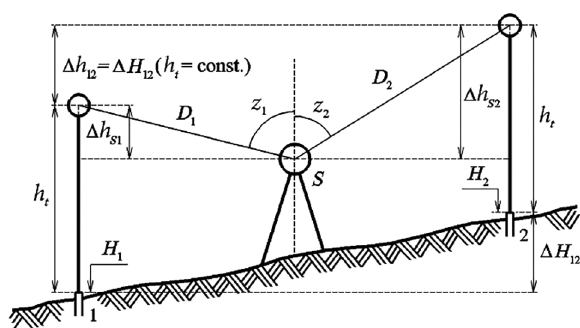
Figure 4. Trigonometric levelling from the centre